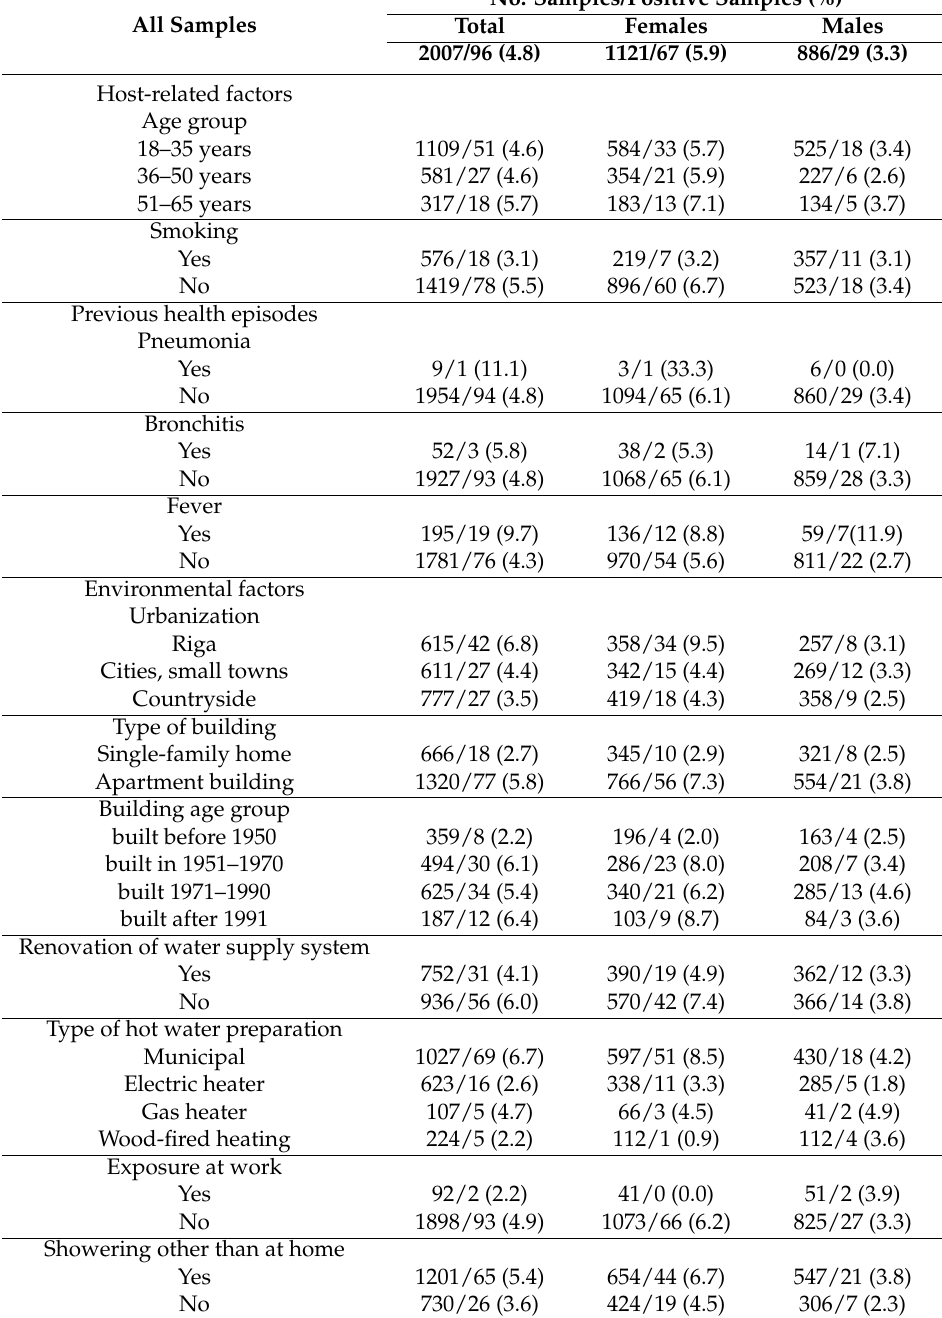
Table 1. Seroprevalence of Legionella pneumophila SG 1–6 in blood